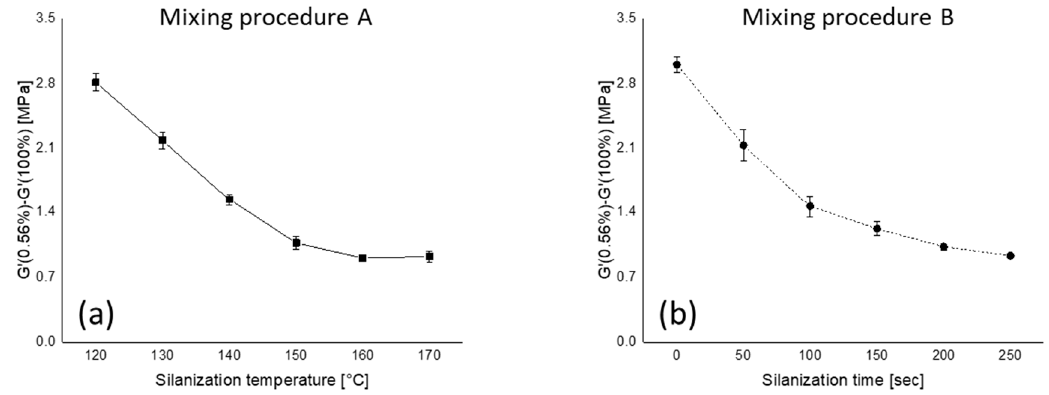
Figure 3. Payne e ff ect as a function of ( a ) silanization temperature and ( b ) silanization Figure 3. Payne effect as a function of ( a ) silanization temperature and ( b ) silanization time.